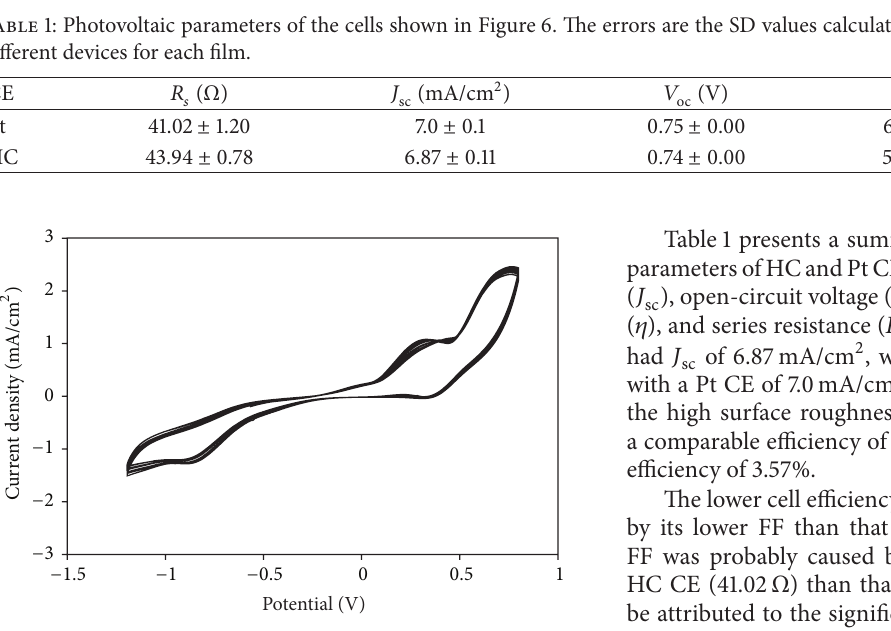
Figure 5: 50 successive cycles of HC CE obtained at a scan rate of 50 mV/s.